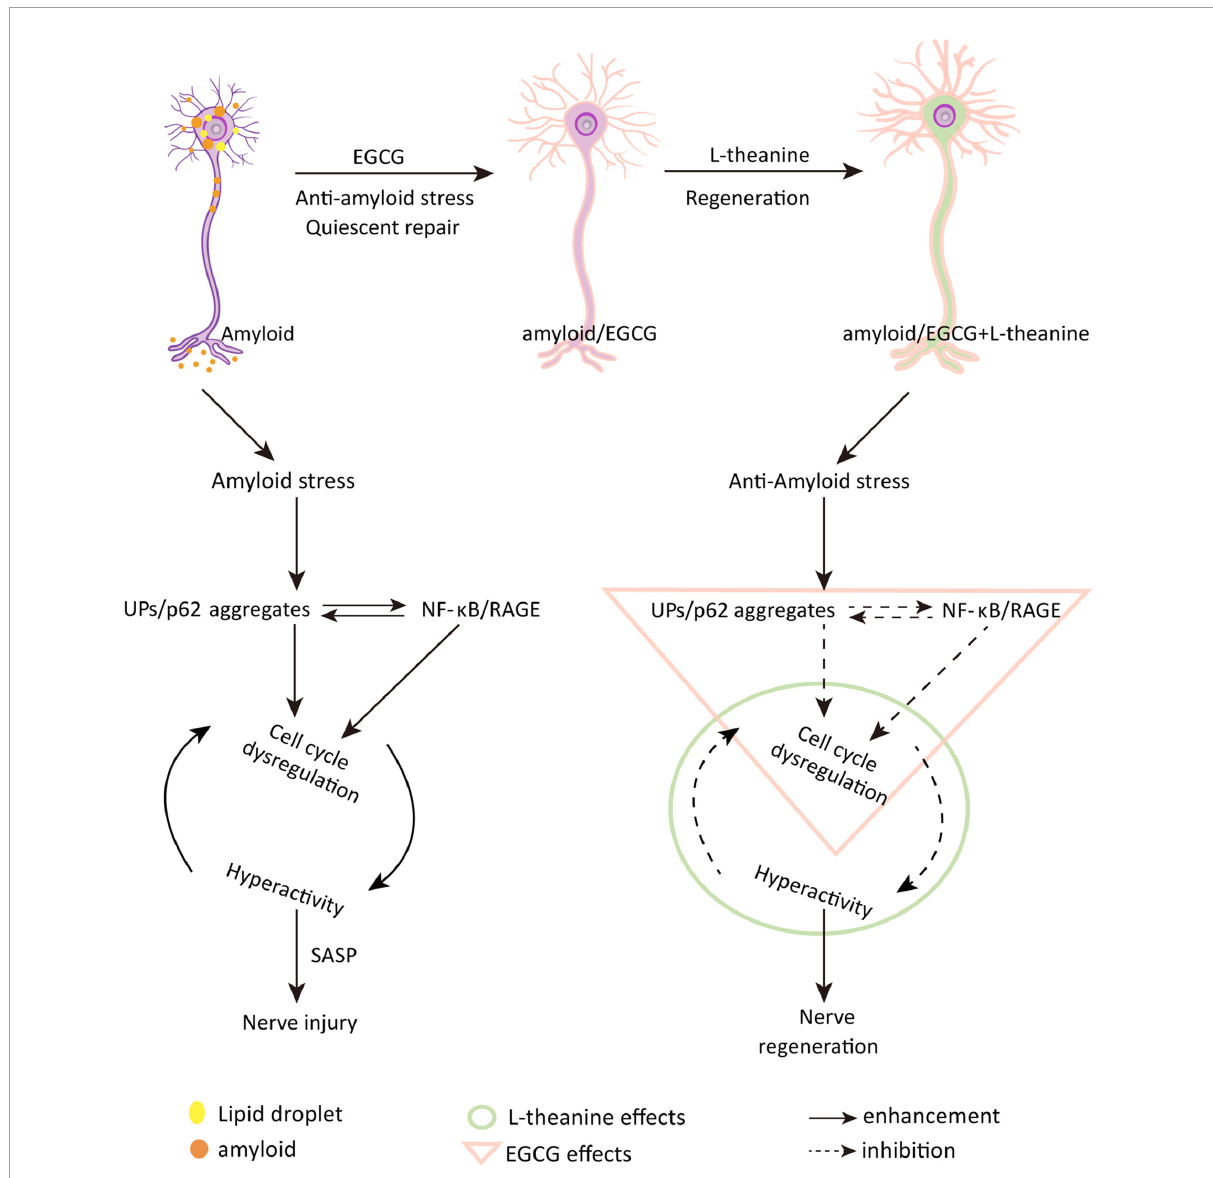
FIGURE10 Schematic diagram of the molecular mechanism by which EGCG and L -theanine synergistically promote nerve cell repair and regeneration under amyloid stress conditions. Epigallocatechin gallate (EGCG) and N -ethyl- L -glutamine ( L -theanine) are the representative functional components of green tea (Camellia sinensis). This study investigated the synergistic protective effect of EGCG and L -theanine on neural cells by establishing an AD model of A β 25 − 35 -induced differentiated neural cell line PC12 cells. Through a series of cell and molecular biology experiments, it was found that amyloid stress mainly promotes the accumulation of UPs/p62-modified aggregates, upregulates the NF- κ B/RAGE inflammatory pathway, stimulates cell-cycle dysregulation, and leads to cell hyperactivity and damage; EGCG + L -theanine can repair and regenerate amyloid-stressed differentiated neural cells. The synergistic mechanism is that under the premise that EGCG inhibits amyloid stress and inflammation and promotes metabolism, L -theanine can nourish nerves. EGCG + L -theanine increases the G0/G1 phase, down-regulates the expression of cyclins, keeps the cells in a quiescent state, and is beneficial to the repair and regeneration of the differentiated neuronal cells. In addition, EGCG + L -theanine maintains the high-fidelity structure of cellular proteins. This study revealed for the first time that the synergistic effect of EGCG with L -theanine or drinking green tea may be an effective way to promote nerve cell repair and regeneration and slow the progression of AD.